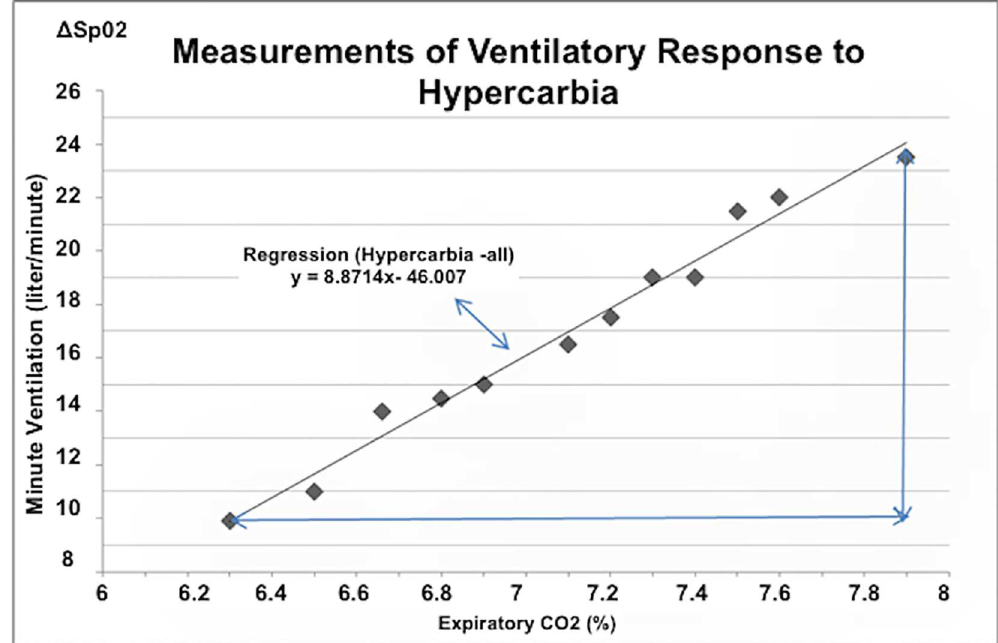
Regression (Hypercapnia-all) . Hypercapnia-all is the change in V e ( Δ V e ) between baseline and the end of the study, divided by the reciprocal change in EtCO 2 ( Δ EtCO 2 ) in the following form: HCVR = Δ V e / Δ CO 2 . Regression (Hypercapnia-all) is the slope of regression line of all measurements.